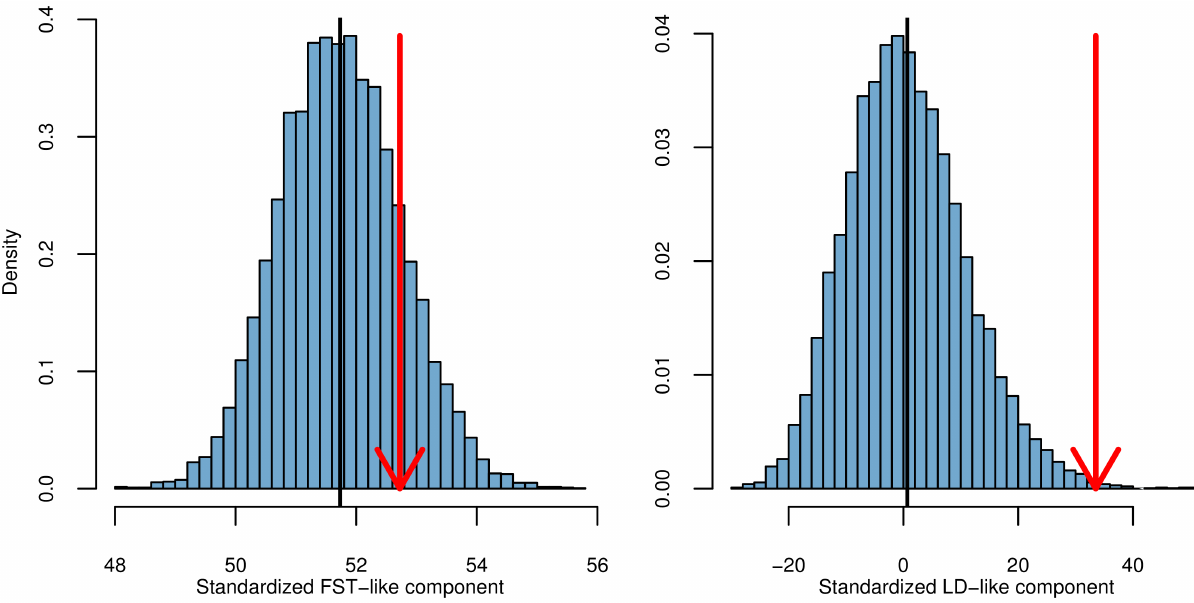
Figure 4. The two components of Q X for the height dataset, as described by the left and right terms in (14). The null distribution of each statistic is shown as a histogram. The mean value is shown as a black bar, and the observed value as a red arrow.